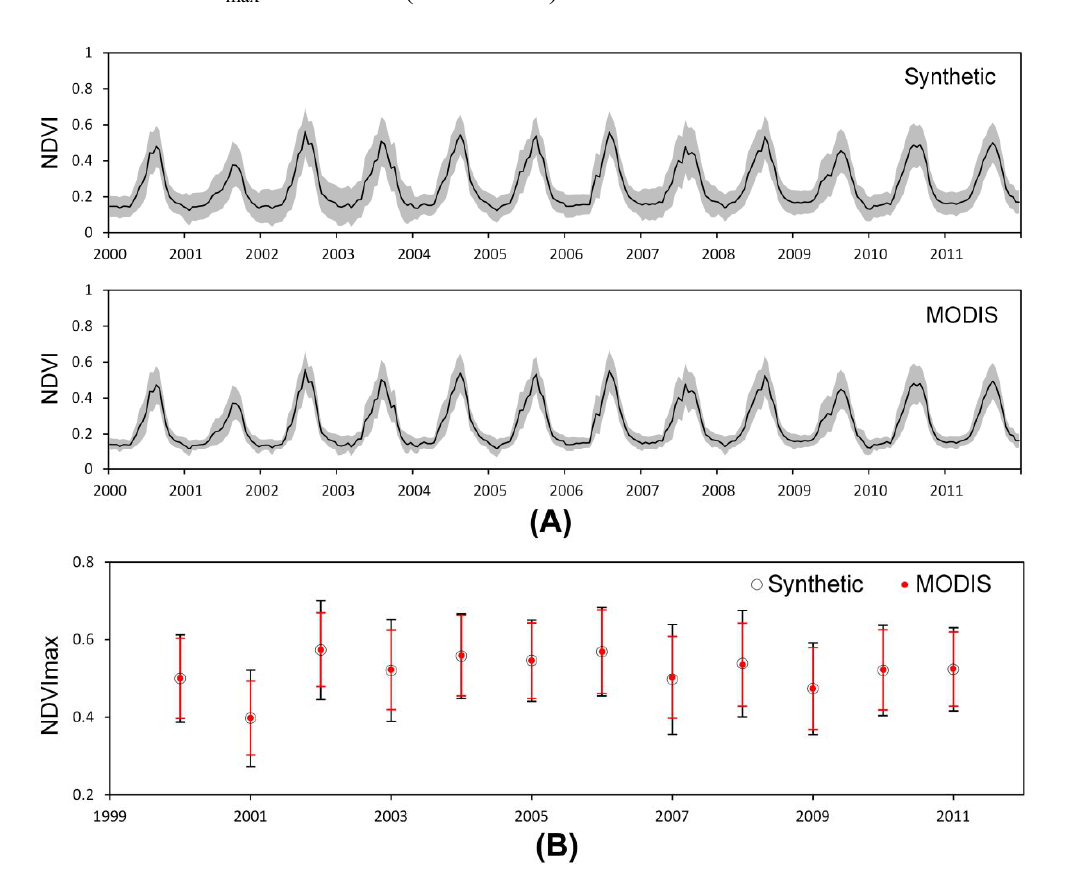
Figure 5. ( A ) Mean (black solid lines) and standard deviation (gray areas) values of the images in synthetic and MODIS dense NDVI time series (2000–2011). ( B ) Mean (black circles and red dots) and standard deviation (vertical bars) values of the images in synthetic and MODIS NDVI time series max